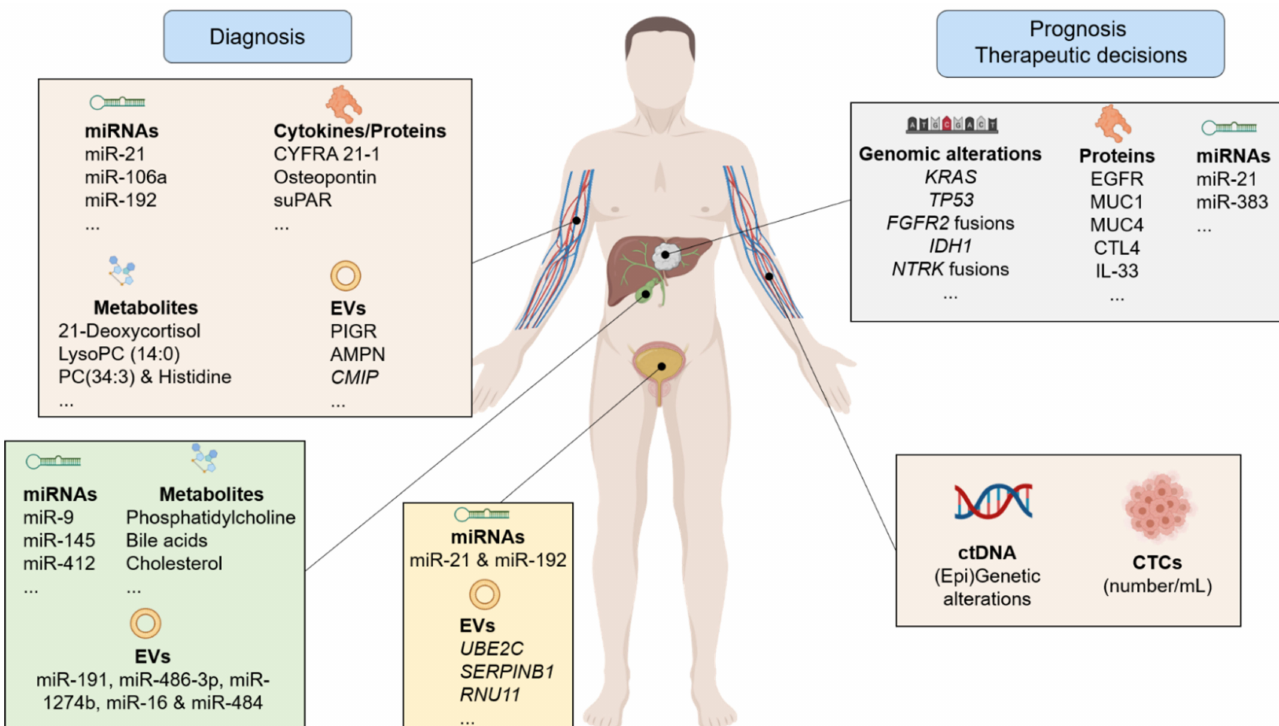
Figure 1. Next-generation biomarkers for cholangiocarcinoma. Created with